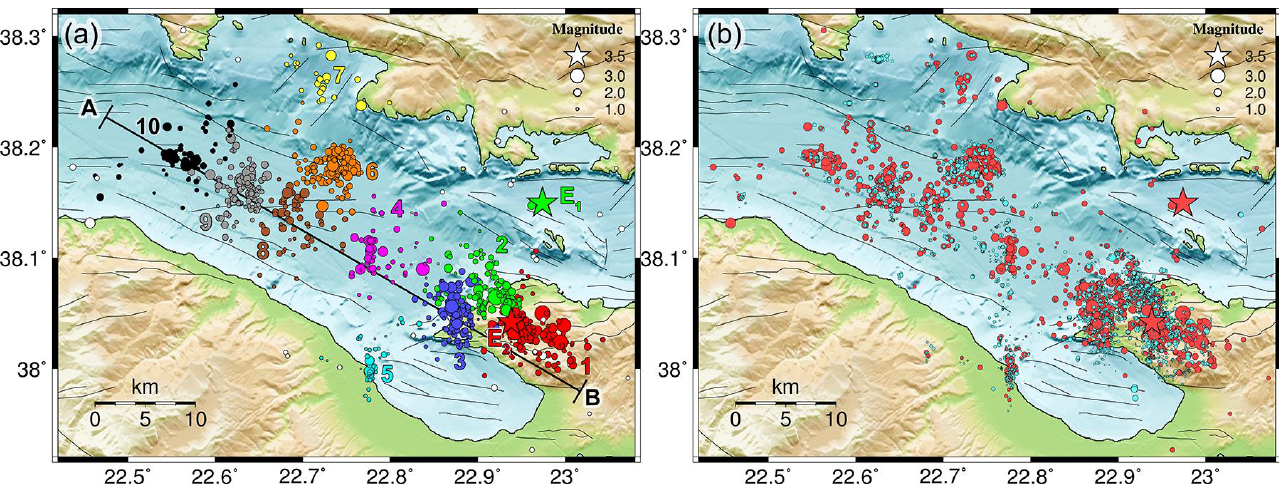
Figure 3. Map of seismicity in the Eastern Gulf of Corinth between January 2020 and June 2021. ( a ) Catalog of routinely analyzed relocated events (CAT1), also used as templates, with different colors and numbers representing 10 different spatial groups. White color is used for events not incorporated into a spatial group. E 1 denotes a major isolated event (green star) with M w = 3.9 that occurred on 7 March 2020 in the Alkyonides gulf; E 2 is the major M w = 3.7 event of 23 June 2020 at Perachora (red star). ( b ) Catalog of templates (red) and relocated detections (cyan) from CAT3. Only detections with a calculated relative magnitude are displayed.